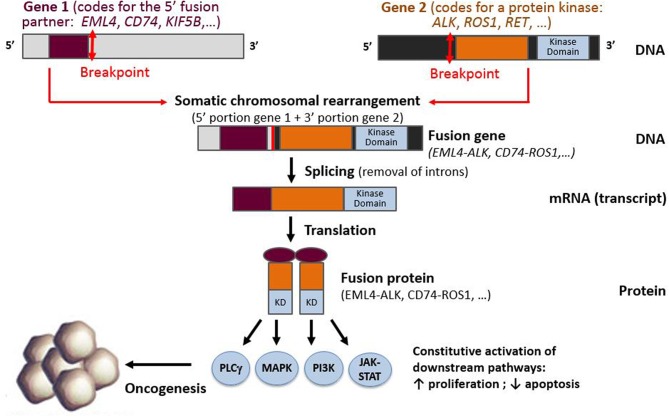
Schematic representation of a fusion between the 3′ portion of a protein kinase gene (containing the kinase domain) and 5′ part of a fusion partner gene, resulting in the production of a fusion gene, fusion transcript, and fusion protein.